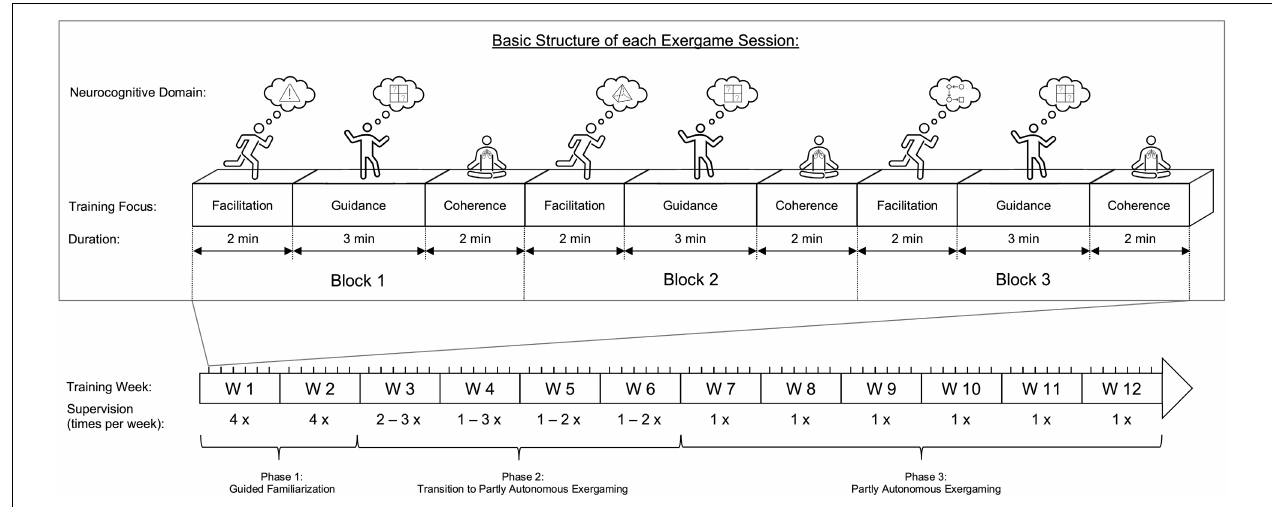
FIGURE 2 | Overview of the exergame-based intervention concept and the basic structure of each exergame session (here as an example for a patient with amnestic-single domain mNCD with a training focus on learning and memory in week